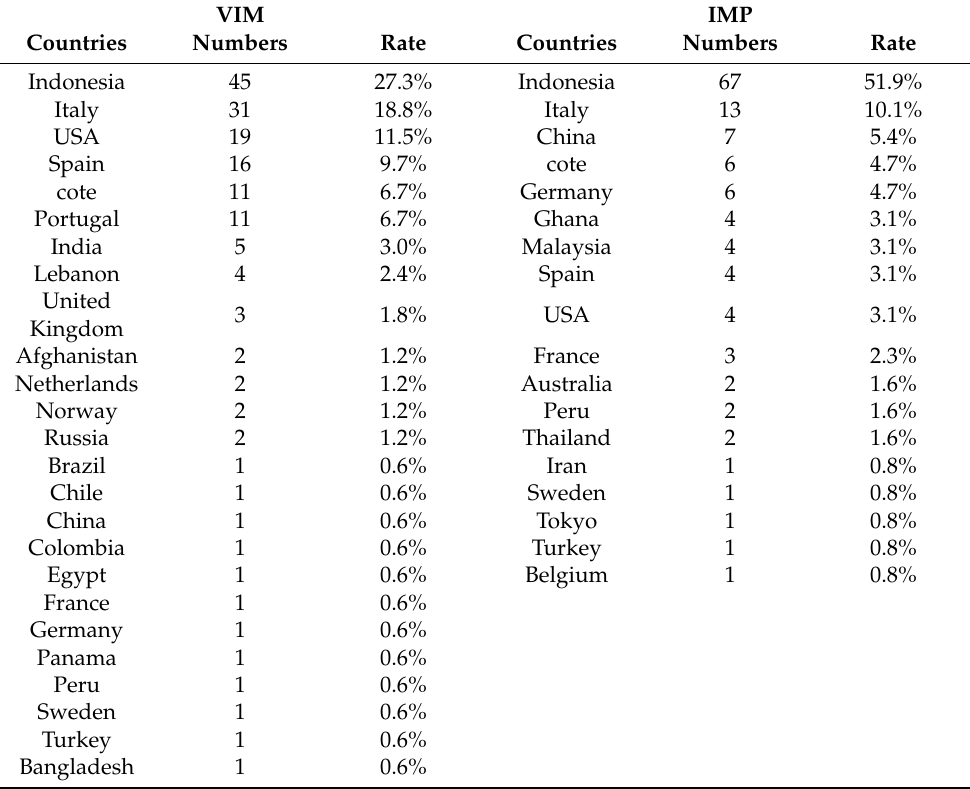
Table A2. Distribution of VIM- and IMP-positive P. aeruginosa in various countries.